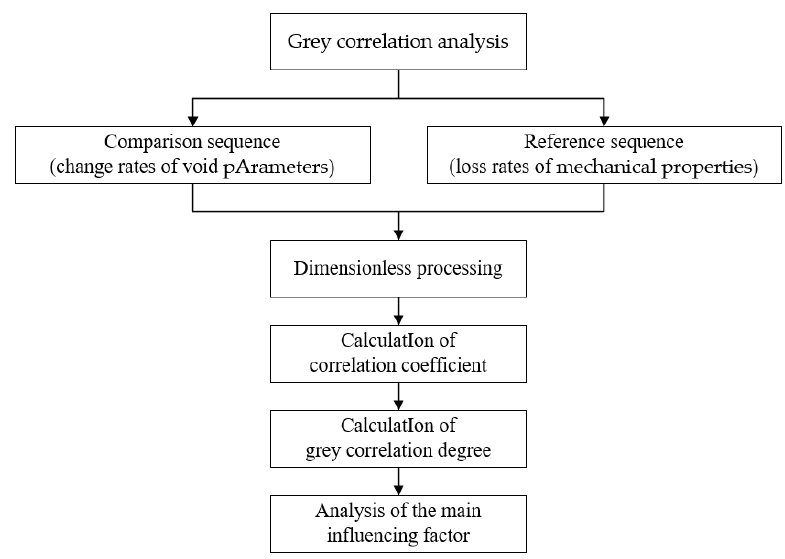
Figure 10. Correlation between mechanical damage and meso characteristics of asphalt mixture.